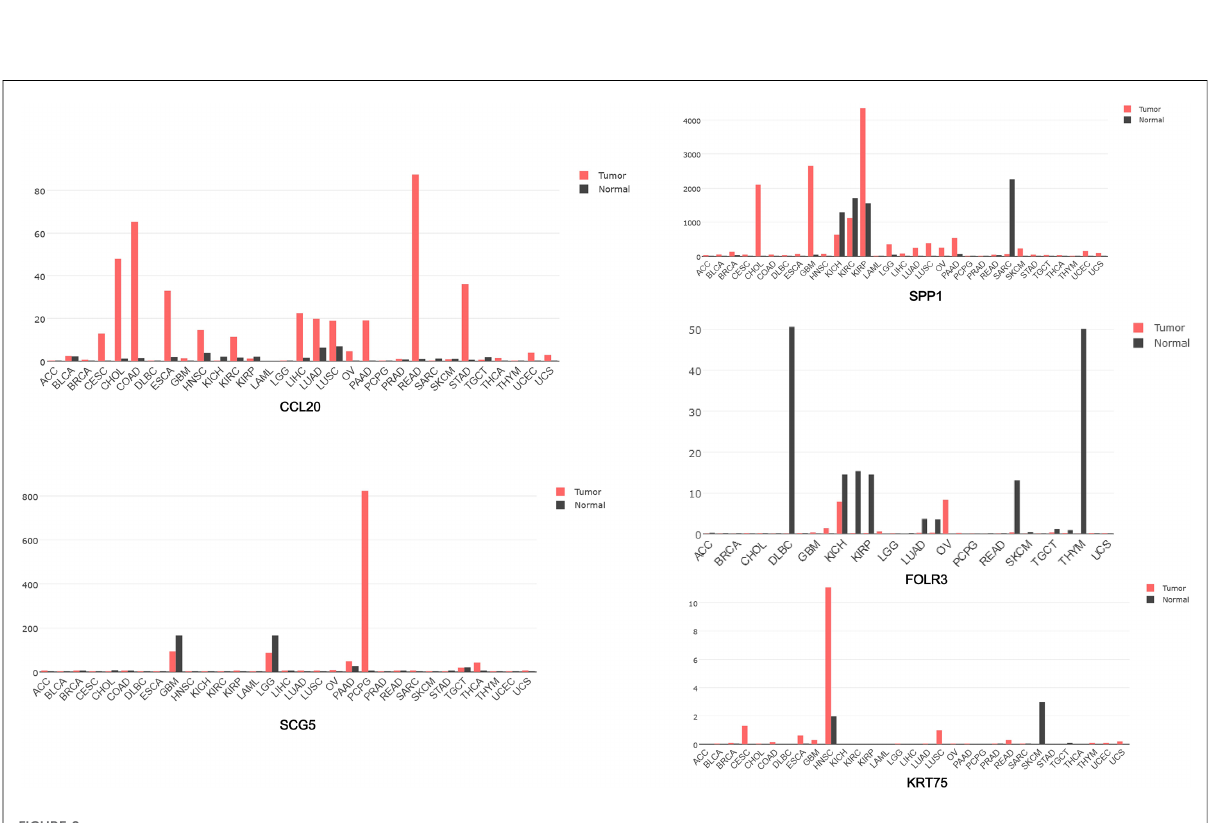
FIGURE 8 GEPIA software used to analyze the expression of fi ve genes CCL20, SCG5, SPP1, FOLR3, and KRT75 in each cancer